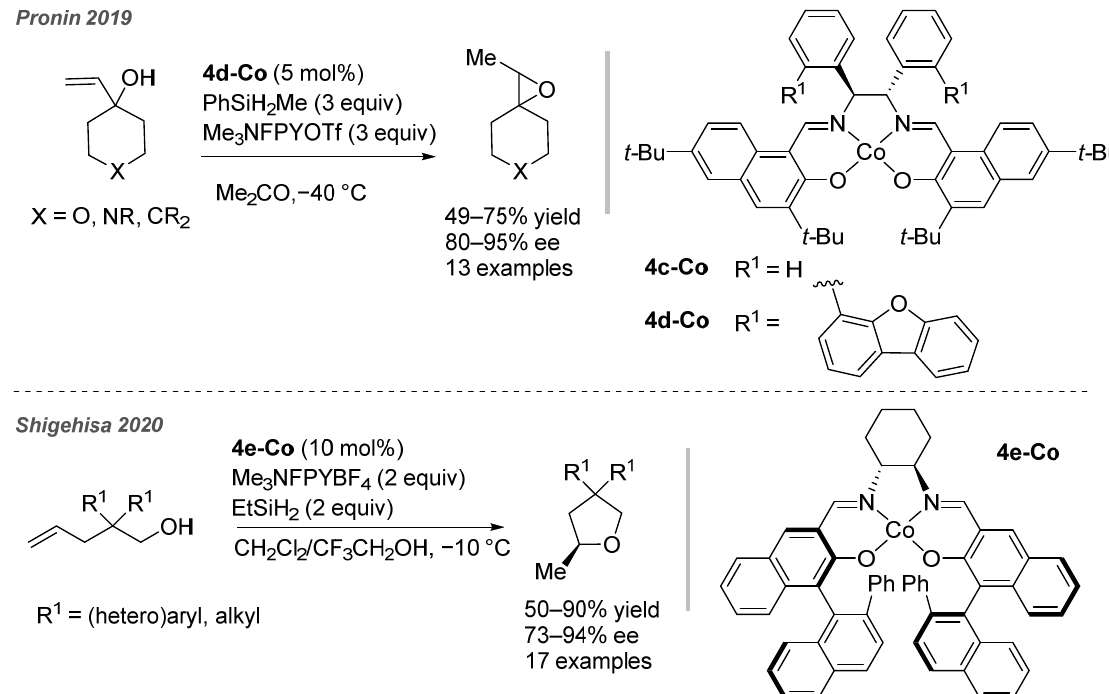
Figure 11. Co-salen-catalyzed asymmetric hydroalkoxylation of vinylic and homoallylic alcohols. ee = enantiomeric ex- cess